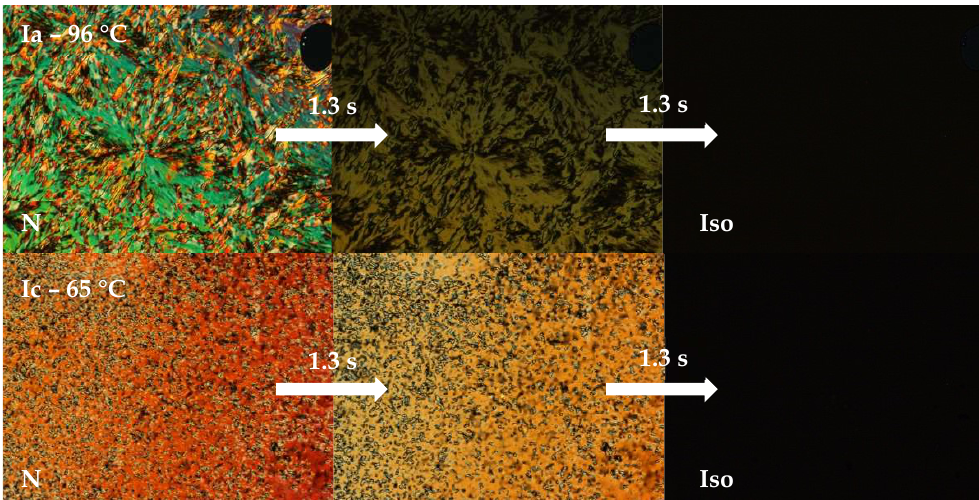
Figure 8. Photos of isothermal photo-triggered phase transition of materials Ia and Ic, observed in POM. Complete transition to isotropic liquid was finished within less than 3 s.